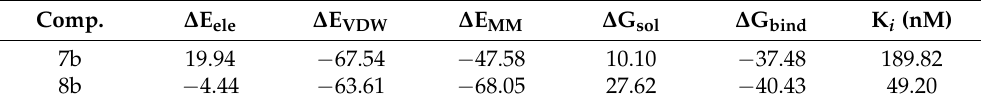
Table 3. Binding energy of AChE with the compounds (kcal/mol). Figure 6. Binding mode of AchE (white cartoon) with the compounds 7b ( A ) and 8b ( B ). The blue dotted lines represent H-bonds. The interaction residues are shown as purple sticks, the compound 7b as a red salmon stick and the compound 8b as a green salmon stick.